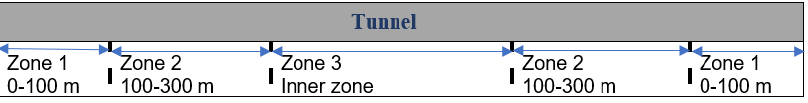
Figure 6. Tunnel zones for fire rate distribution. Table 5. Distribution of fire rates based on vehicle type.